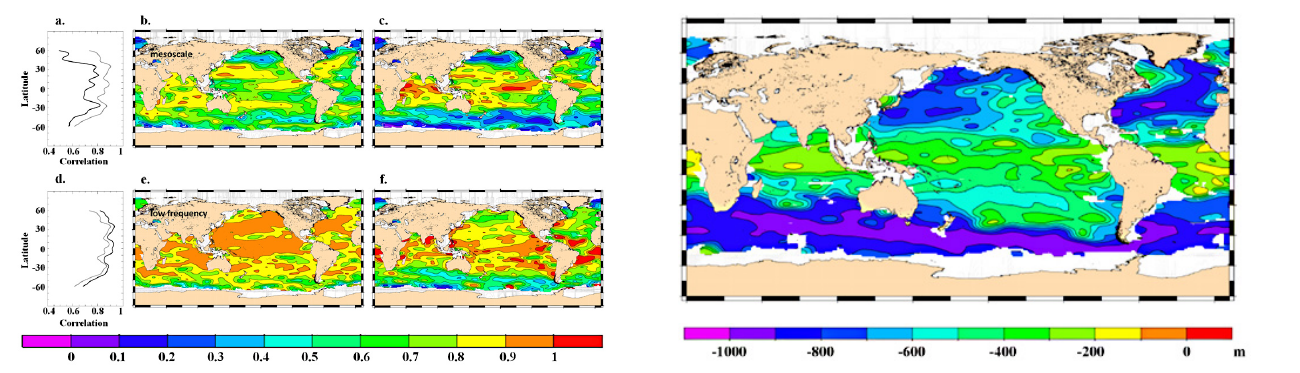
Fig. 4. Correlation coefficient (b, e) and regression coefficient (c, f) between SLA and DHA for the intra-seasonal (mesoscale, top) and low frequency (bottom) signals. The mean correlation as a func- tion of latitude is also represented (a, d) , together with the curve obtained using the total fields (in grey).